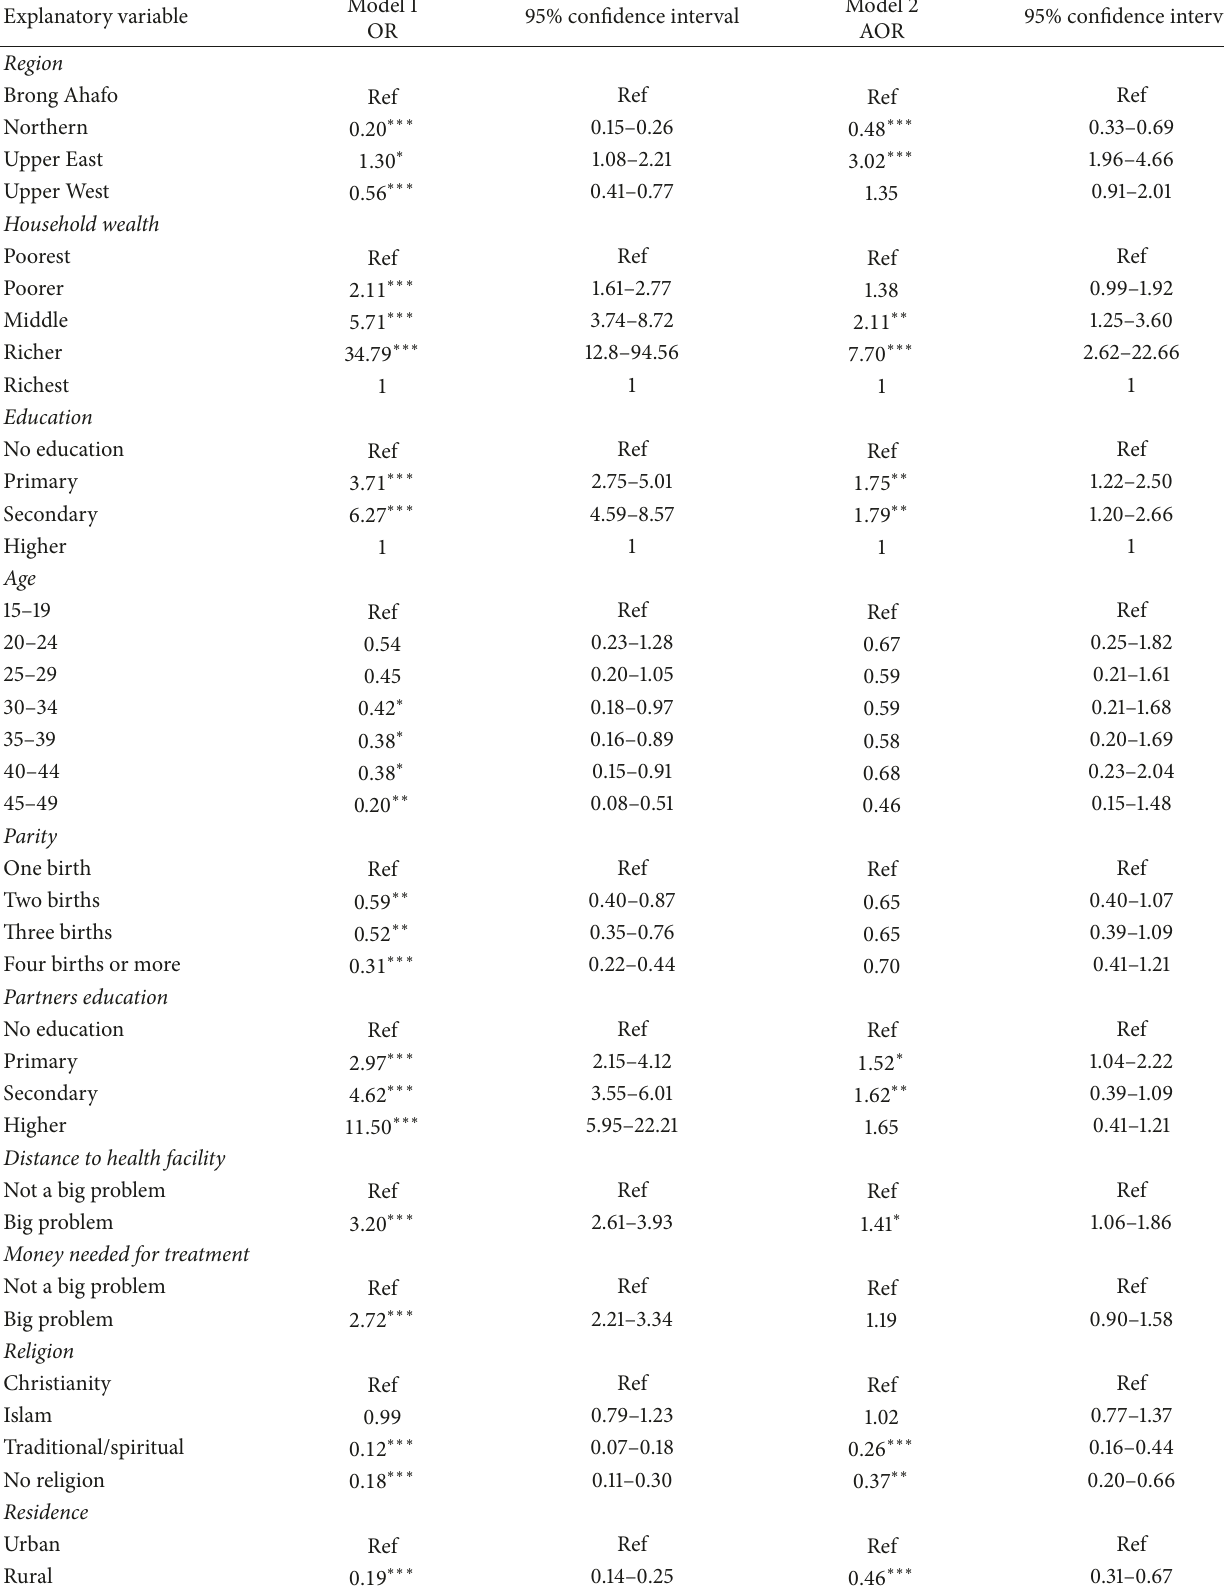
Table 2: Binary logistic regression on skilled delivery among women in the Northern part of